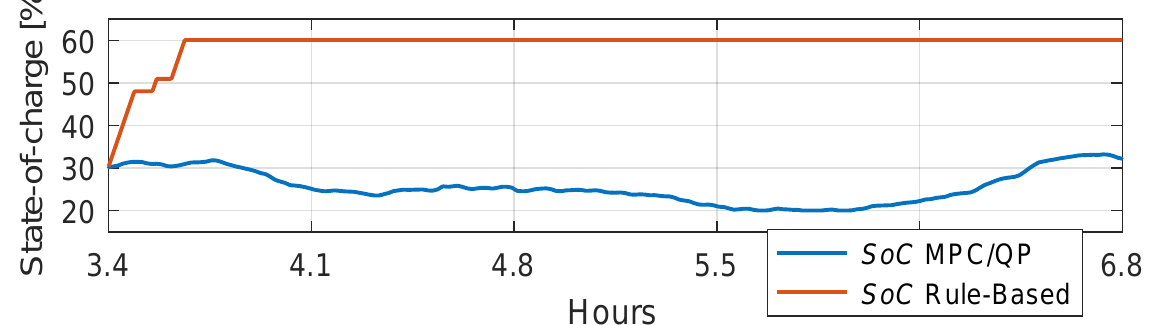
Figure 33. Close view of state-of-charge using MPC/QP and rule-based algorithms in